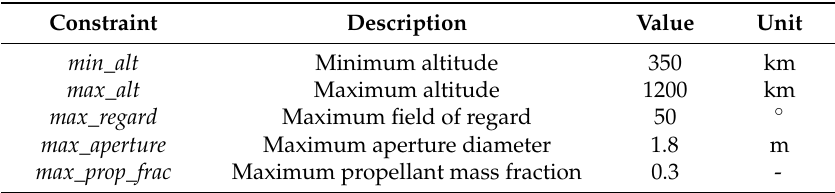
Table 5. Constraints imposed in ReCon simulation.